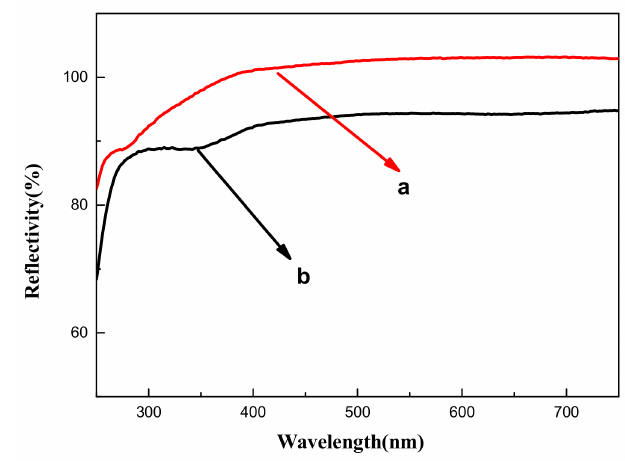
Figure 8. Reflectance spectrum: ( a ) homemade barium sulfate microspheres; ( b ) commercially available barium sulfate.